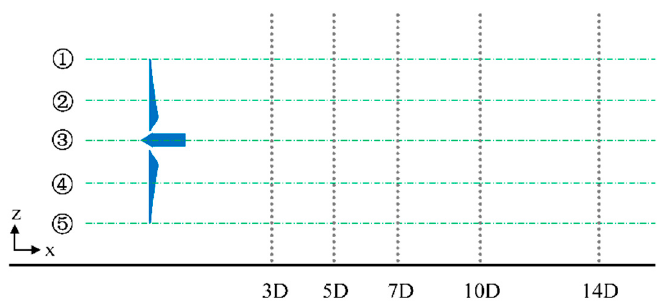
Figure 6. Vertical positions of five points.